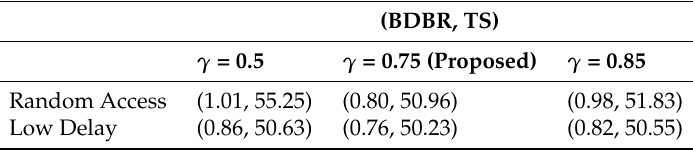
Table 5. Performance comparison of different γ